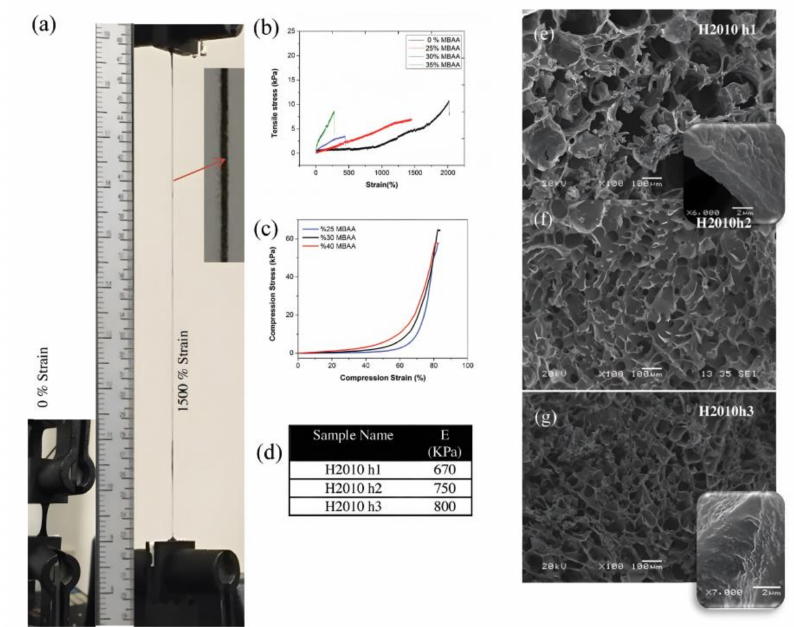
Figure 18. Tensile experiments for hydrogels with different MBAA ratios and SEM images. ( a ) Optical image of the H2010h1 sample with 15 mm length, 5 mm width, and 1 mm thickness without stretch ( left ) and stretched to 1500% ( right ). ( b ) Stress versus tensile strain for the hydrogels with different covalent crosslinker ratios (10 mm/min speed). ( c ) Compressive stress–strain curves and Young’s modulus for hydrogels with different covalent crosslinker ratios (the speed test was conducted at 1 mm/min). ( d ) Compressive modulus of elasticity ( E ). ( e ) SEM images of H2010h1 hydrogel with 25%, ( f ) H2010h2 with 30%, and ( g ) H2010h3 with 35% MBAA. Reprinted with permission from Ref. [133]. Copyright 2017, Darabi, M.